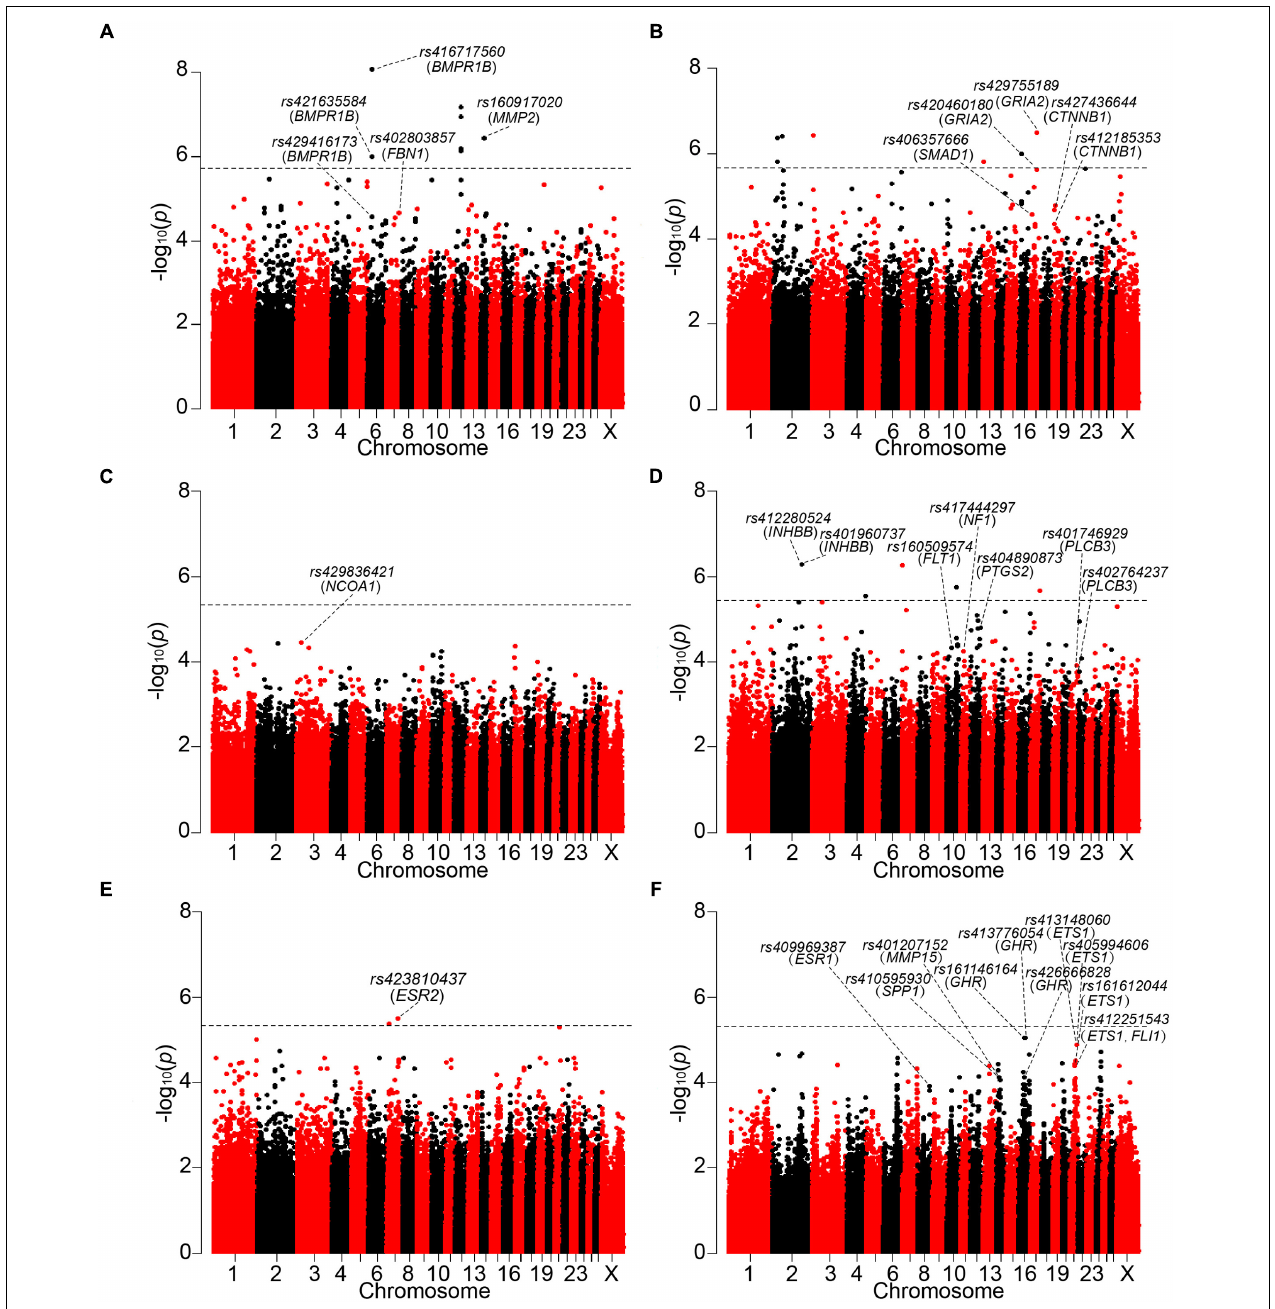
FIGURE 3 | Manhattan plots of GWAS are shown on (A) Wadi, (B) Hu, (C) Icelandic, (D) Finnsheep, (E) Romanov and (F) Texel sheep. The 5% genome-wide significant threshold value is indicated by a dotted line. The significant SNPs surrounding the genes previously reported to be associated with reproduction are annotated at the chromosome-wise and genome-wide 5% significance after the Bonferroni correction.